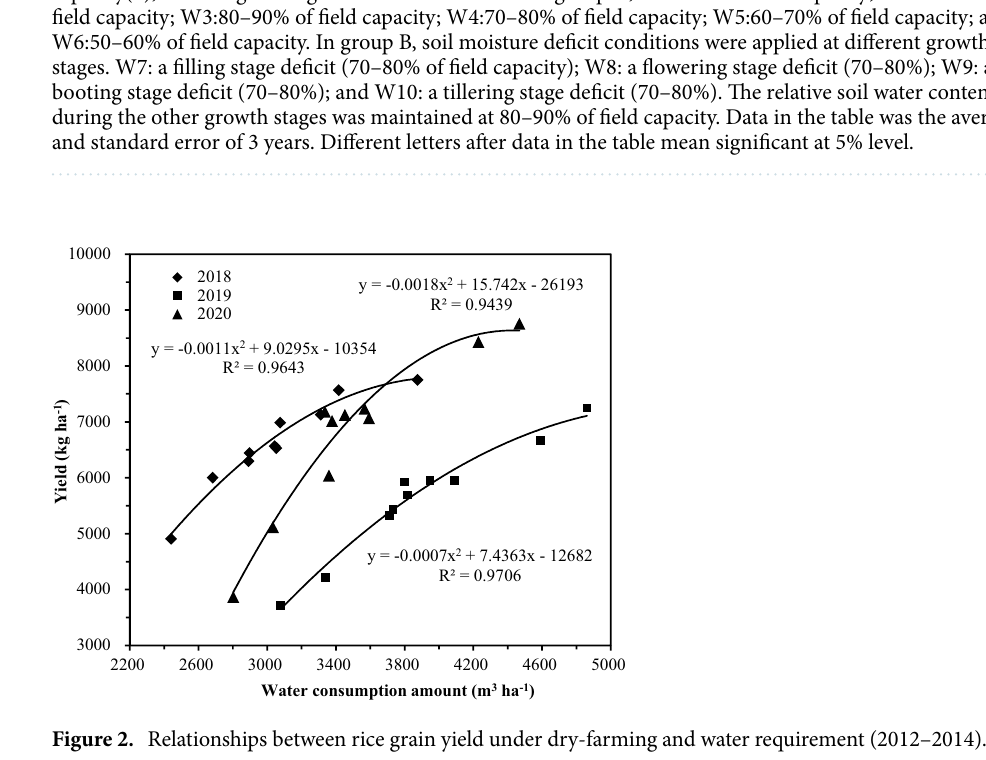
Figure 2. Relationships between rice grain yield under dry-farming and water requirement (2012–2014).